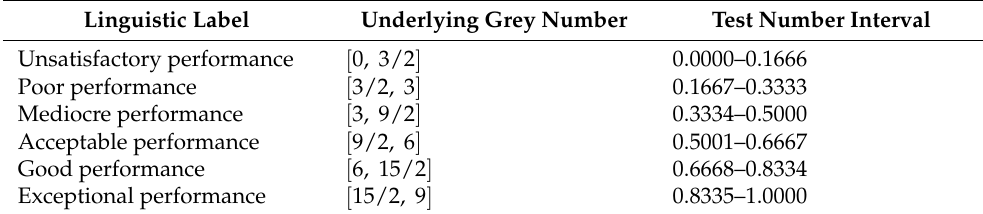
Table 2. Linguistic label set for assessments. Linguistic